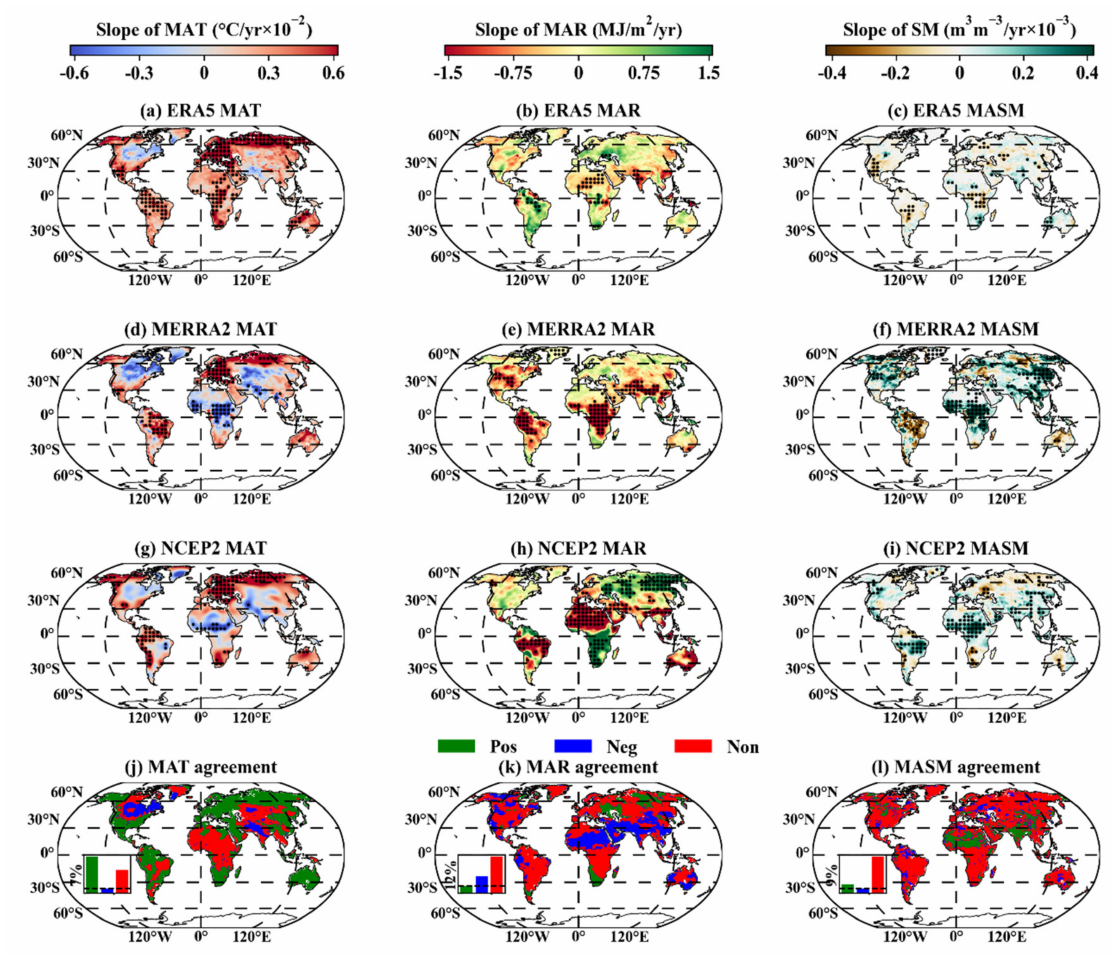
Figure 4. Spatial patterns of the trends of MAT ( a , d , g ), MAR ( b , e , h ), MASM ( c , f , i ) (derived from ERA5, MERRA2, and NCEP2), and their spatial consistencies ( j , k , l ) from 2001 to 2020. The frequency of the uncertainty value is in the left of subfigures ( j , k , l ). The regions with black dots indicate that the trend is statistically significant at the 0.05 level. “Pos” and “Neg” denote the regions with the positive and negative agreement, respectively. “Non” denotes that the regions have not reached an agreement (the same meaning